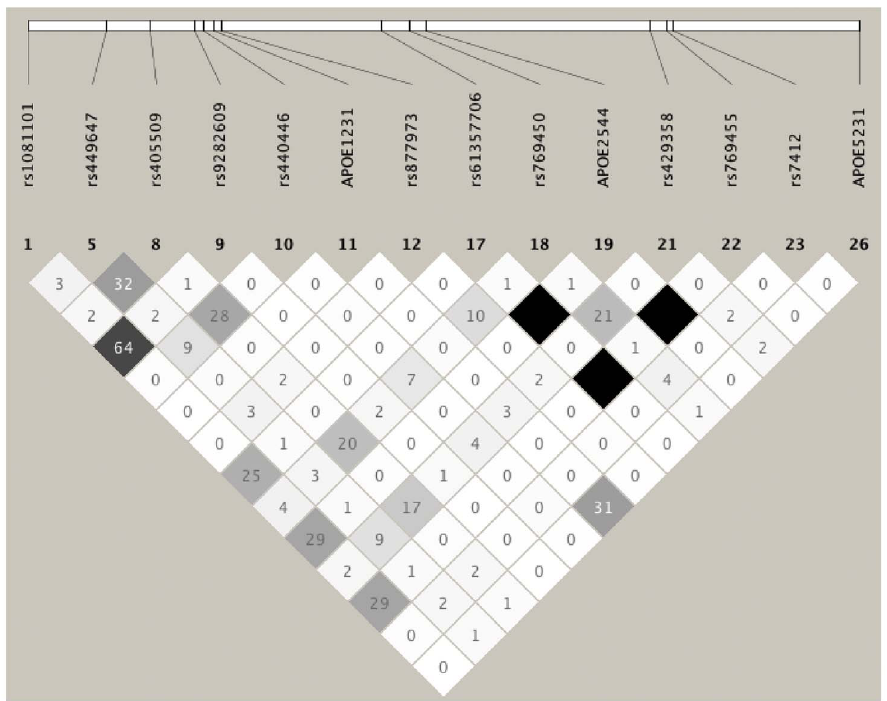
Fig. 2. LD Plot of the genotyped variants with MAF . 1% in African Blacks. The values in the cells are the pairwise degree of LD indicated by r 2 6 100. r 2 5 0 is shown as white, 0 , r 2 , 1 is shown in gray and r 2 5 1 is shown in black.